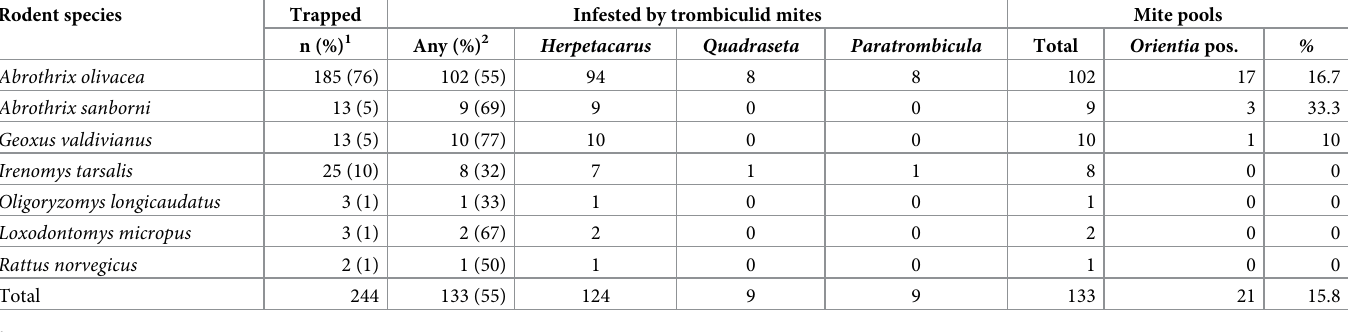
Table 1. Infestation with different genera of trombiculid mites and infection of mite pools with Orientia species per rodent species in 244 rodents captured between January and February 2018 on Chiloe´ Island. Rodent species